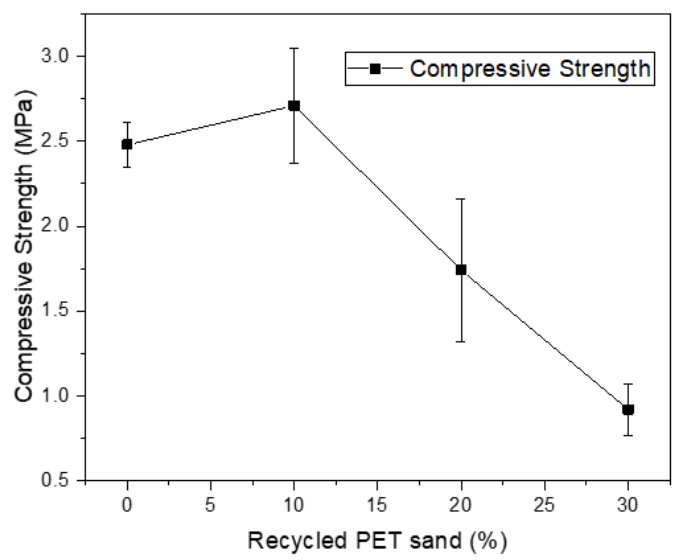
Figure 6. Compressive strength results.